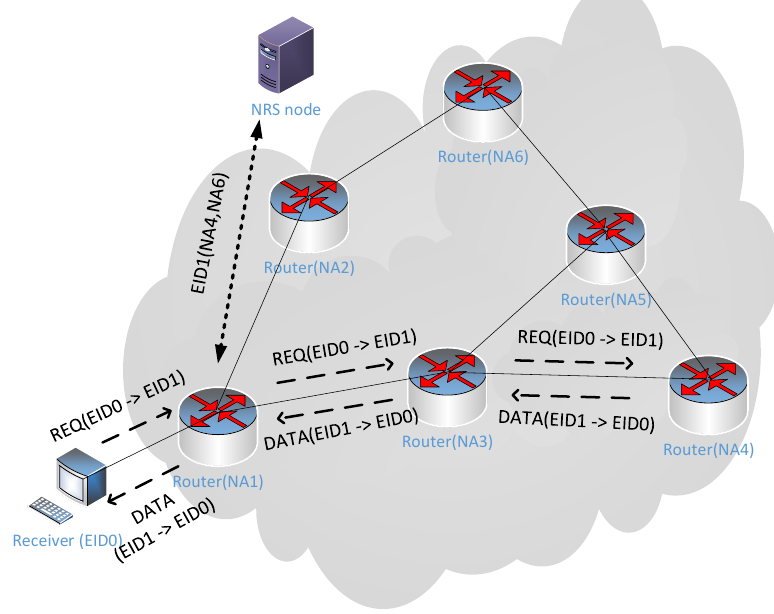
Figure 1. NDC transmission in ICN